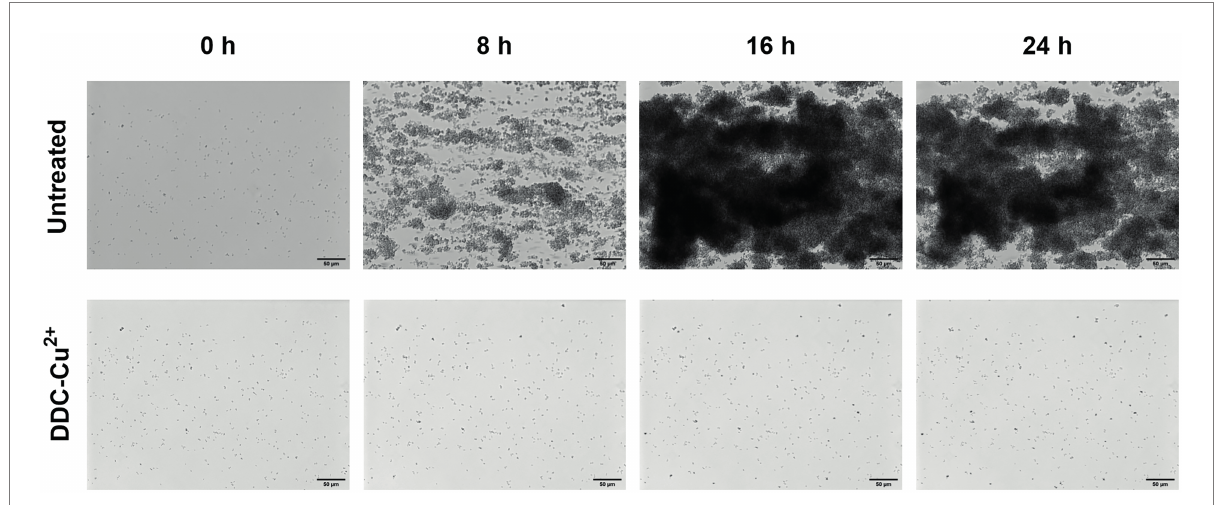
FIGURE 4 Monitoring of MRSA Mu50 biofilm formation over 24 h when left untreated or treated with a combination of 8 μ g/ml diethyldithiocarbamate and 32 μ g/ml Cu 2+ combination (DDC-Cu 2+ ) using the Bioflux system. Scale bar represents 50 μ m.